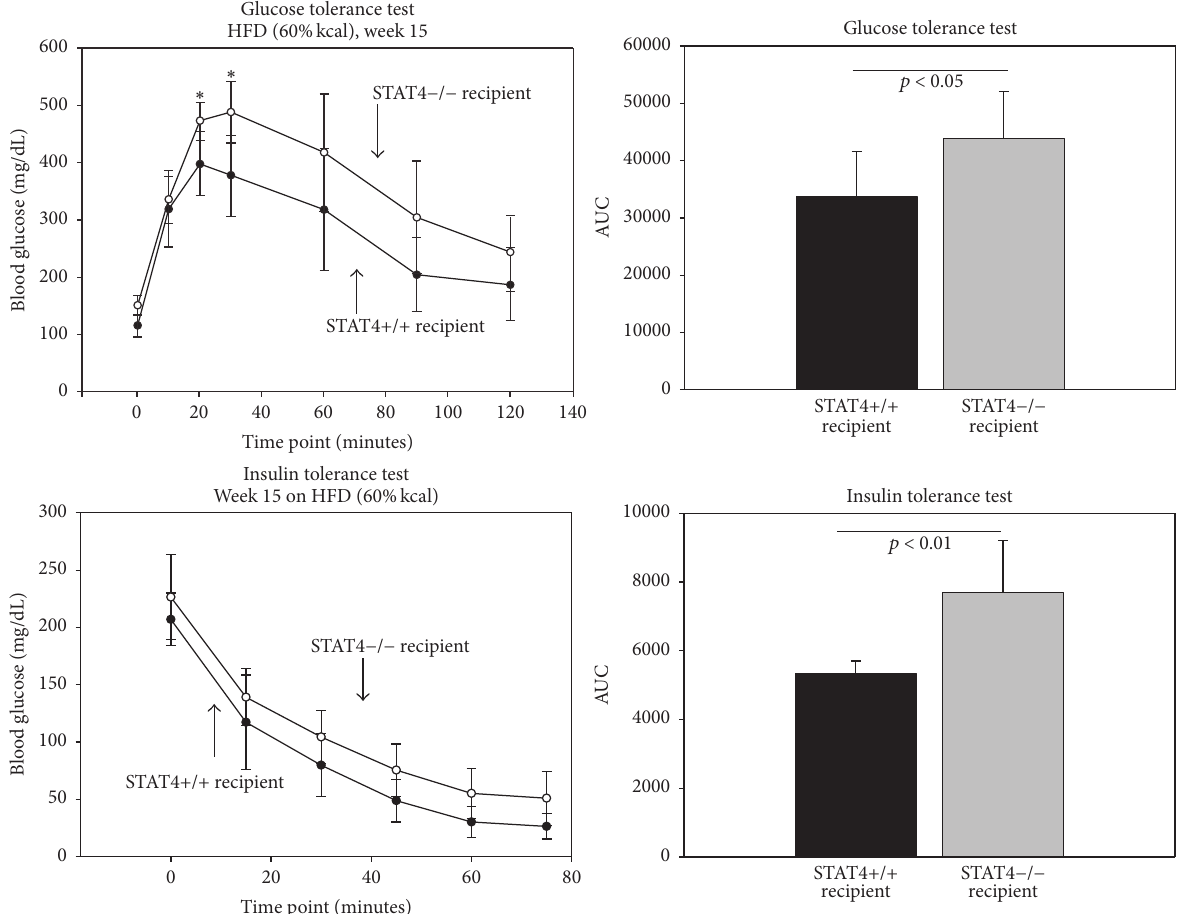
Figure 1: Intraperitoneal glucose tolerance test (GTT) and insulin tolerance test (ITT) were performed after 15 weeks of HFD. For both the ITT and the GTT, STAT4 − / − recipients that received STAT4+/+ bone marrow cells had significantly higher area under curve (AUC) compared to STAT4+/+ recipients that received STAT4 − / − cells. Data represents average ± SD from 7 mice/group. The null hypothesis was rejected for a 𝑝 value < 0.05; ∗ 𝑝 < 0.05